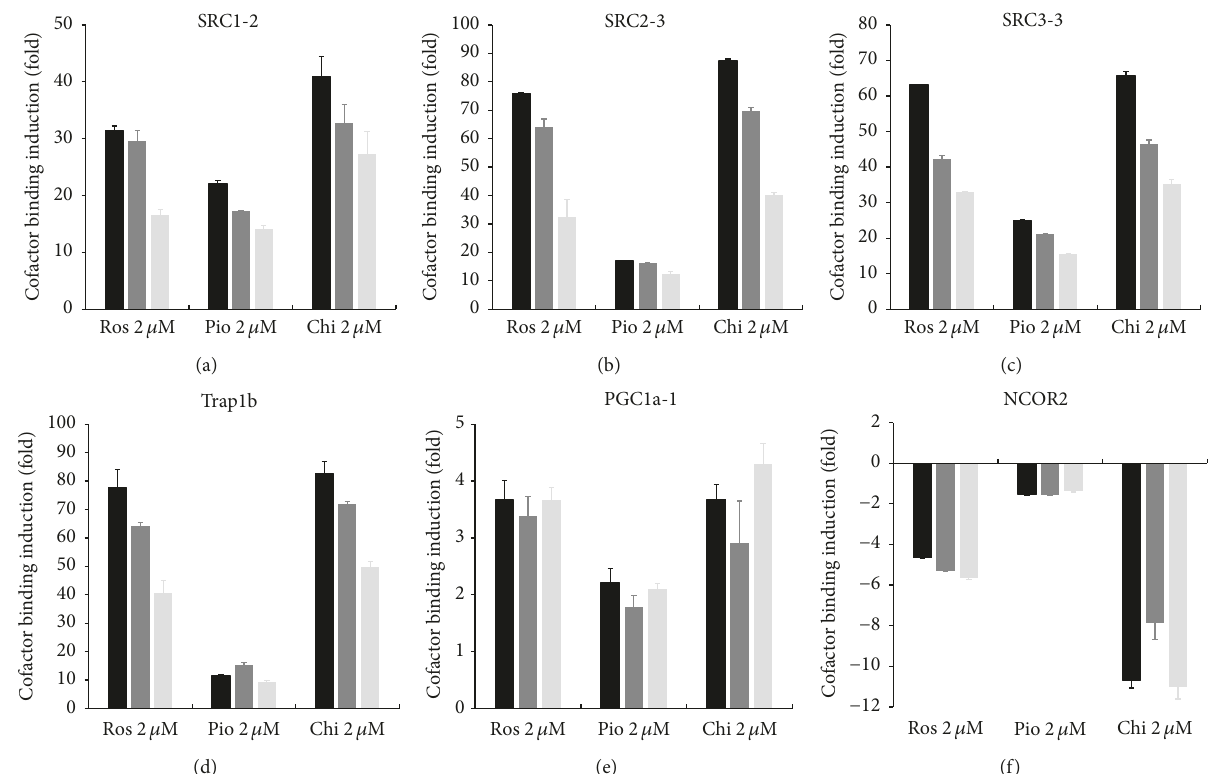
Figure 7: Chiglitazar differentially affects cofactor recruitment upon CDK5-mediated phosphorylation. AlphaScreen assay was performed to evaluate the recruitment of six representative LXXLL peptides to PPAR 𝛾 -LBD following treatment with 2 𝜇 M of Chi, Ros, and Pio as described in Materials and Methods . The S273 phosphorylation status of PPAR 𝛾 -LBD was varied by adding different components to the in vitro phosphorylation reaction as indicated. For instance, “LBD + CDK5 − ATP + agonist” denotes no phosphorylation completed by active CDK5/p25 without ATP in the reaction (indicated as black bar). “LBD + CDK5 + ATP + agonist” indicates that the phosphorylation was partially repressed in the presence of agonist (indicated as grey bar). Finally, “(LBD + CDK5 + ATP) + agonist” signifies that the phosphorylation was completed before the addition of agonist to the reaction (indicated as light grey bar). All reactions were then directly applied to the AlphaScreen assay following a conventional procedure as described in Materials and Methods . The baseline for cofactor recruitment, independent of ligand binding, was calculated using RLUs from reactions performed in the presence of cofactor peptides divided by control reactions lacking peptide (background signal). Induction of cofactor recruitment by agonist is represented in fold change using RLUs from the cofactor binding reaction with agonist divided by the vehicle control sample (0.1% (vol/vol)